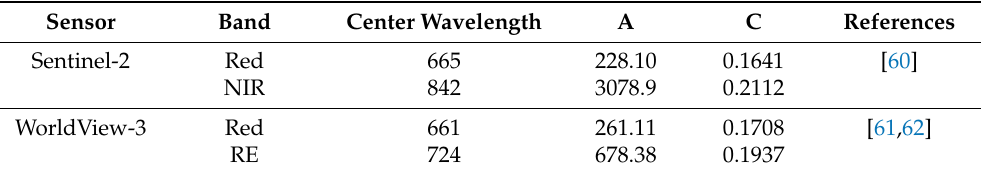
Table 3. Turbidity coefficients used for each band per satellite sensor. The nearest wavelength was used to choose the appropriate calibration coefficients (A and